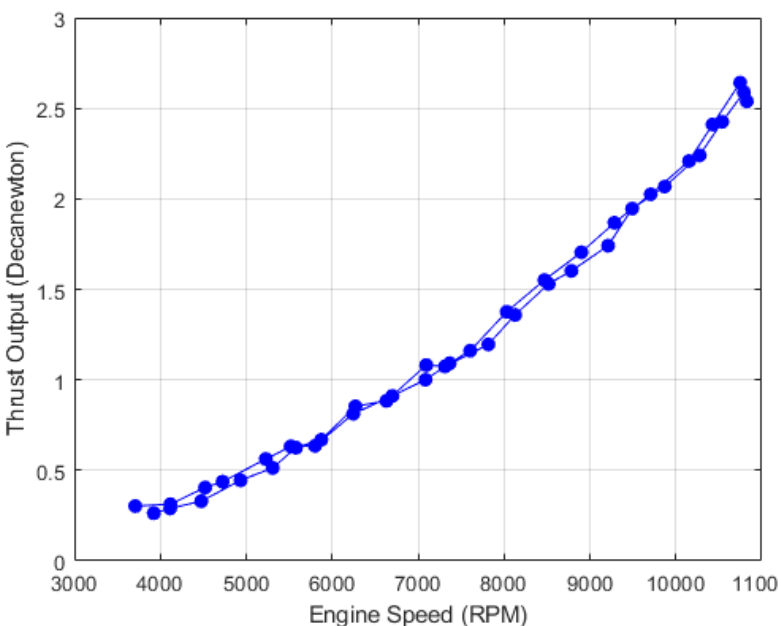
Figure 11. Thrust produced by a single engine at various speeds.